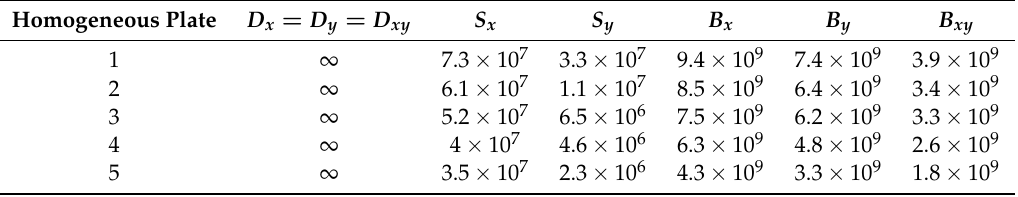
Table 2. Identified equivalent stiffness coefficients (in N/m) for the LW homogenized model. Homogeneous